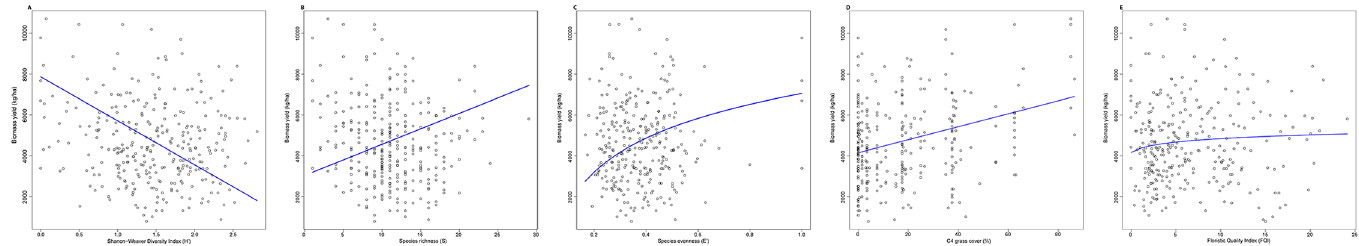
Fig 5. Variable plots for the model average for 2008 + 2009 data. The regression line for multiple regression is displayed as the intercept and slope for the indicated predictor variable with the mean of all other variables held constant. Coefficients for each model are listed in Table 4. Log-transformed variables have been back-transformed. (A) The relationship between the Shannon-Weaver diversity index (H 0 ) for the plant community within 1 m2 plot and biomass yield (kg/ha). (B) The relationship between plant species richness (S) within 1 m 2 plots and biomass yield (kg/ha). (C) The relationship between plant species evenness (E 0 ) within 1 m 2 plots to biomass yield (kg/ha). (D) The relationship between the percent of C4 grass cover within 1 m 2 plots to biomass yield (kg/ ha). (E) The relationship between the Floristic Quality Index (FQI) within 1 m 2 plots to biomass yield